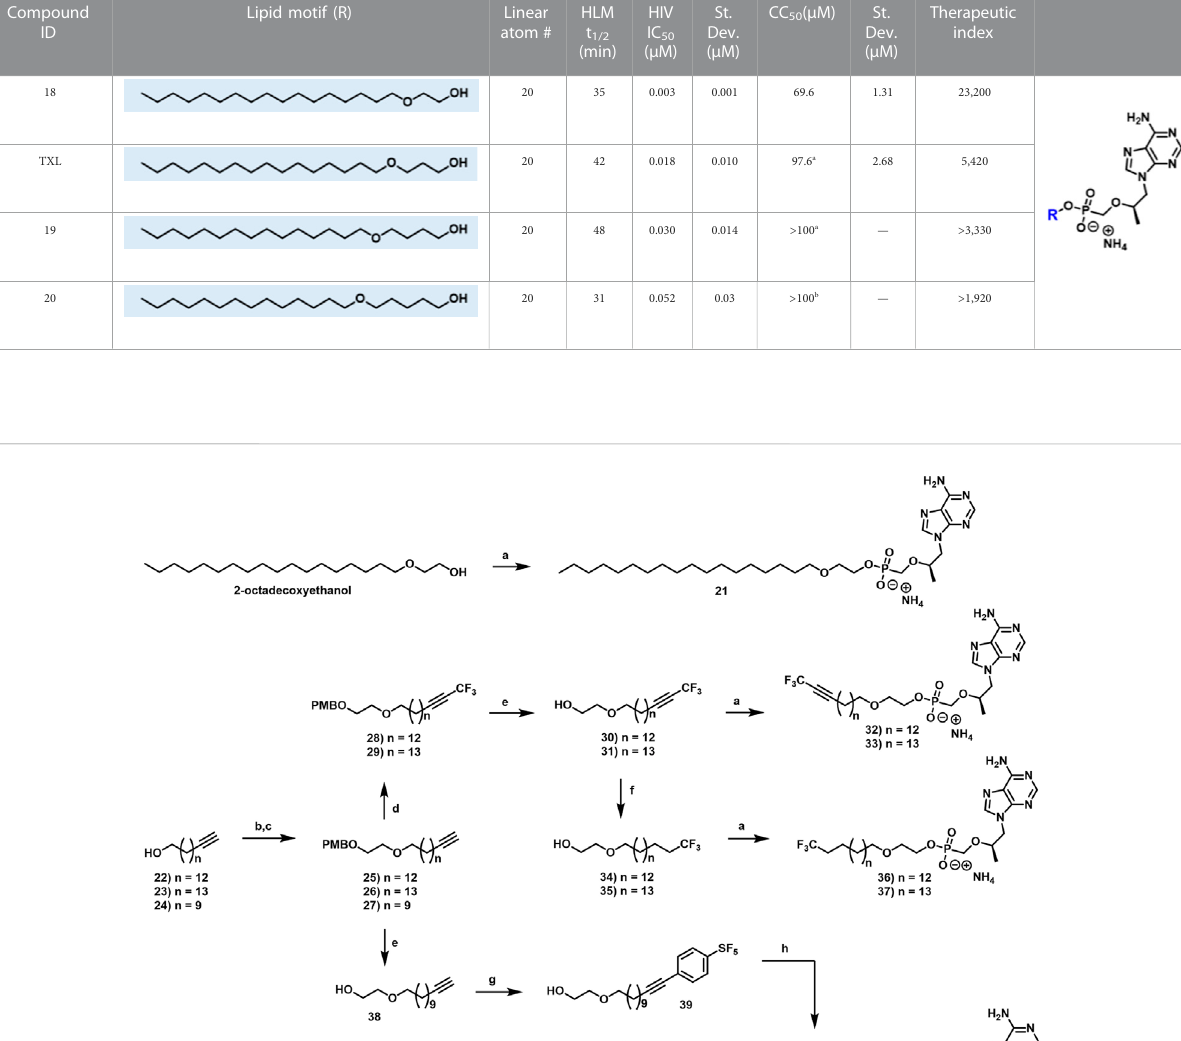
TABLE 2 In vitro activity pro fi les of lipid prodrugs of TFV featuring increasing distances between phosphorus and oxygen. All HIV and cytotoxicity results compounds formulated as HSA complexes in 5: 1 M ratios. Nd = not determined. Lipid motif Compound ID